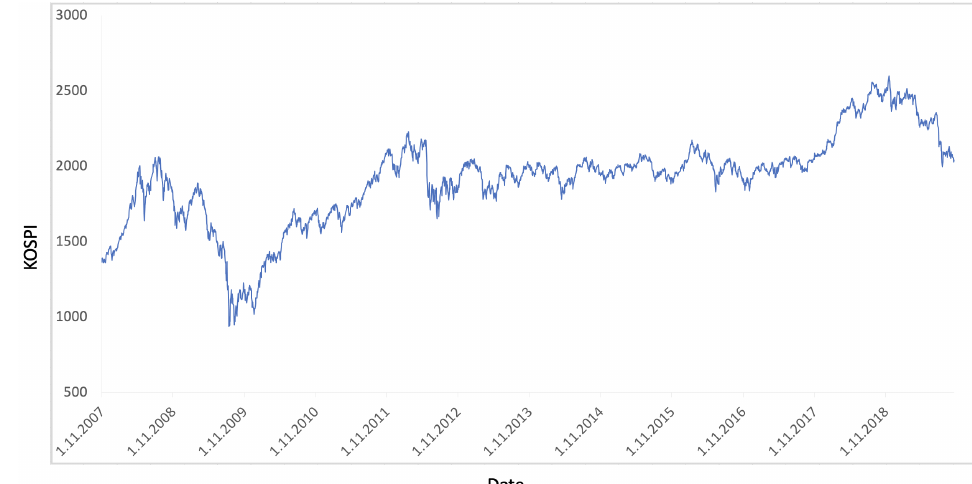
Figure 6. Daily KOSPI from 2007 to